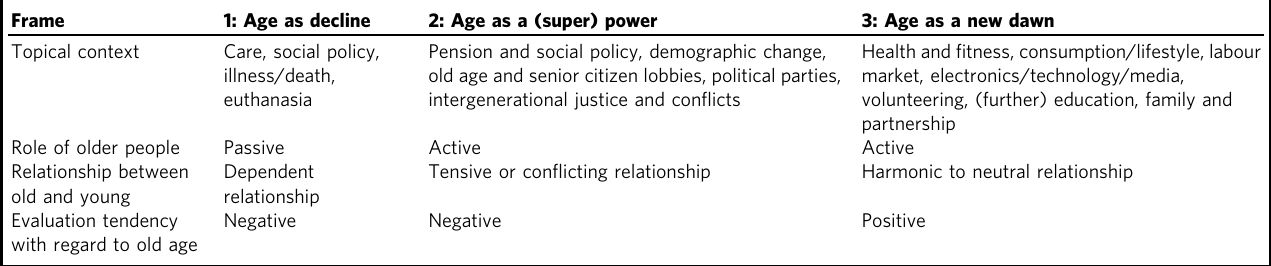
Table 1 Frame description based on selected